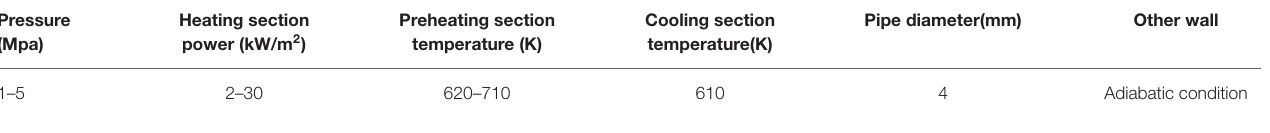
TABLE 2 | Parameter